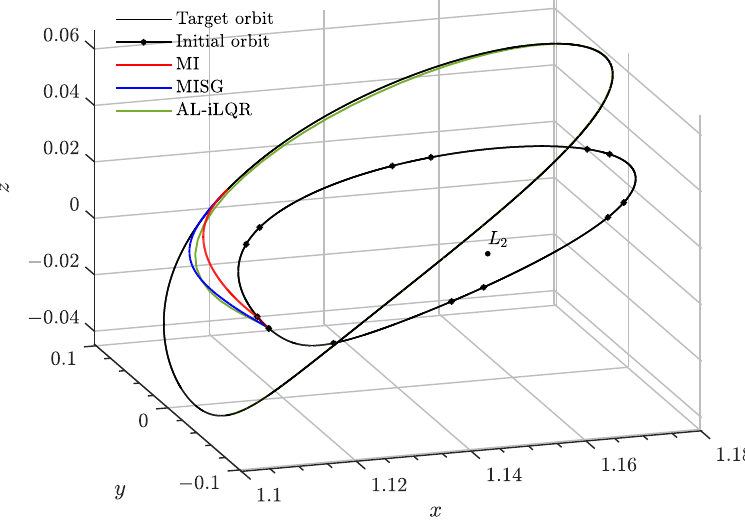
Figure 3. Rendezvous trajectory in the absolute configuration space for the MI, MISG and AL- iLQR